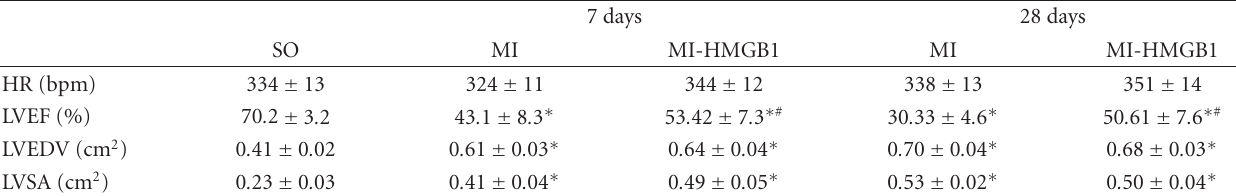
Table 1: Cardiac function in SO, MI, and MI-HMGB1 group at 7 and 28